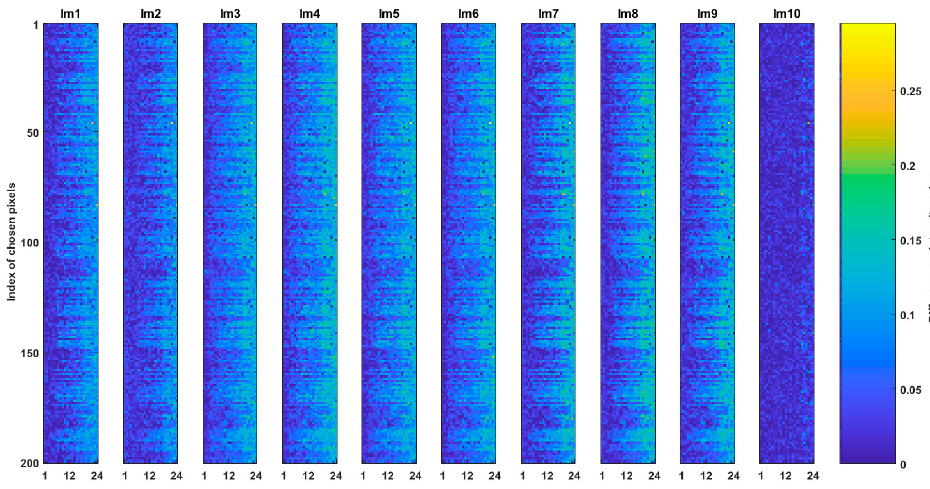
Figure 11. Comparison of 𝐻𝑒𝑥 (cid:3004)(cid:3006)(cid:3046)(cid:3044) and 𝐻𝑒𝑥_𝐸 (cid:3043) . In each case of CSE_sq or CSE_hex, the intensity average and variance in the 24 tonal sub-ranges of ten corresponding pixel sets of each 𝐻𝑒𝑥_𝐸 (cid:3004)(cid:3006)(cid:3046)(cid:3044) , 𝐻𝑆_𝐸 (cid:3004)(cid:3006)(cid:3046)(cid:3044) , 𝑆𝑄 (cid:3004)(cid:3006)(cid:3042)(cid:3045)(cid:3034) or 𝐻𝑒𝑥_𝐸 (cid:3004)(cid:3006)(cid:3042)(cid:3045)(cid:3034) , 𝐻𝑆_𝐸 (cid:3004)(cid:3006)(cid:3035)(cid:3032)(cid:3051) , 𝑆𝑄 (cid:3004)(cid:3006)(cid:3035)(cid:3032)(cid:3051) are shown in Figures 12 and 13 respectively. The figures show that it is feasible to assess pixels on different arrangements due to the estimation of pixel position and the intensity value in different arrangement by using common space and without the need for any conversion means (see Section 4). The pixel sets from hexagonal arrangement show the highest average intensity value and variance in each type of common space indicating richer intensity variation and larger dynamic range compared to SQ the other pixel sets. Figure 14 shows the mean (a) and variance (b) of ratio values of ten corresponding pixel sets between each SQ and 𝑆𝑄 (cid:3004)(cid:3006)(cid:3035)(cid:3032)(cid:3051) to Hex_E image. The mean (a) shows the nonlinear relation between SQ to Hex_E which was previously shown in [3,18]. The mean (a) also shows that the relation between 𝑆𝑄 (cid:3004)(cid:3006)(cid:3035)(cid:3032)(cid:3051) to Hex_E is similar to the relation between SQ to Hex_E and behaves in a nonlinear manner. The variance (b) shows that the relation between SQ and 𝑆𝑄 (cid:3004)(cid:3006)(cid:3035)(cid:3032)(cid:3051) to Hex_E are similar and nonlinear.